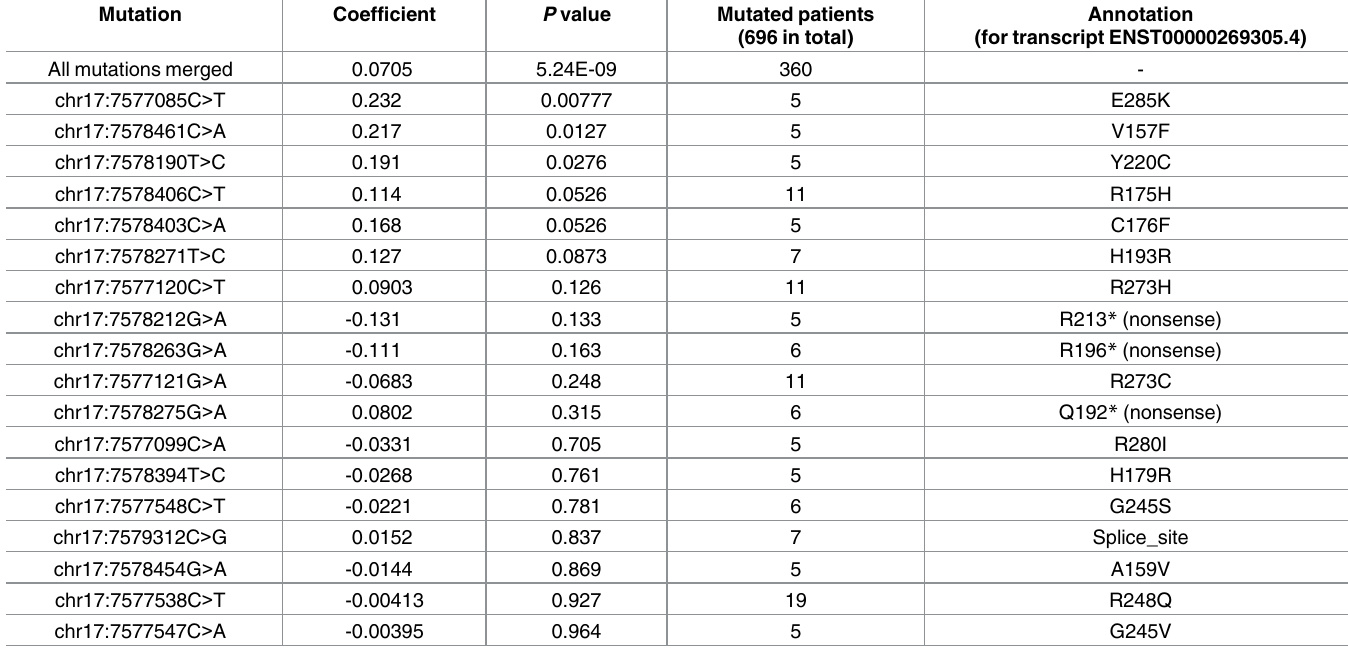
* The association of 5S/ 45S ratio with each specific TP53 mutation that recurred in (cid:21) 5 patients is shown. The first row shows the outcome when all non- silent somatic TP53 mutations are merged. Cancer types were used as a covariate. A positive coefficient indicates a higher 5S /45S ratio in the presence of the mutated TP53